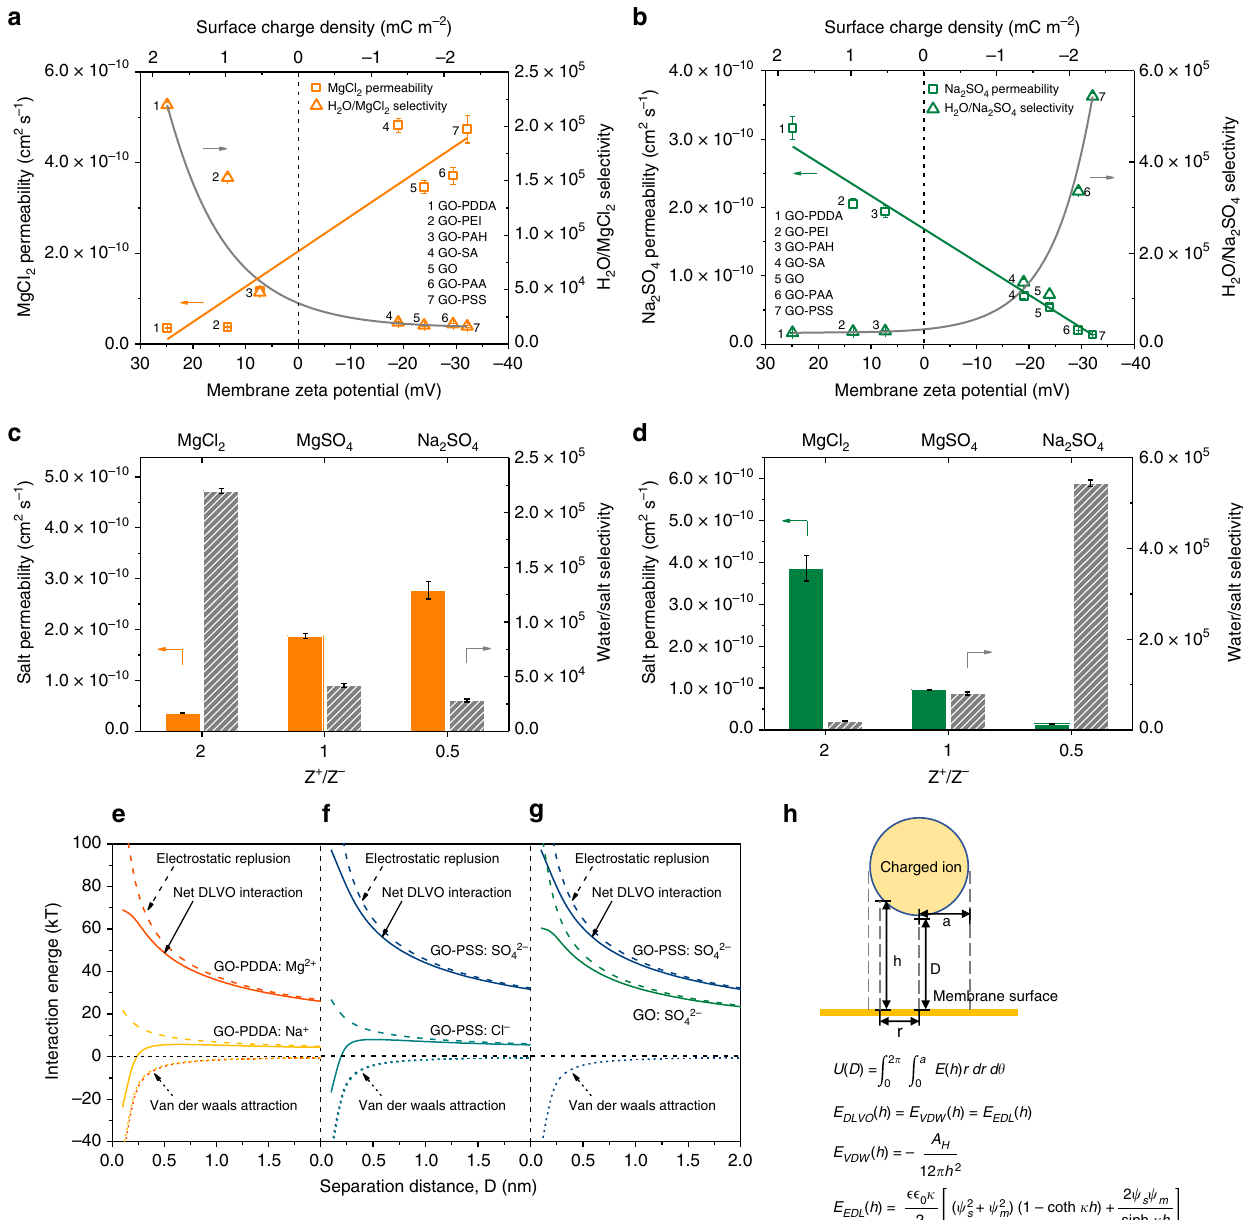
Fig. 2 Ion transport mechanism of surface-charged graphene oxide (GO) membranes. a MgCl 2 permeability and H 2 O/MgCl 2 selectivity and b Na 2 SO 4 permeability and H 2 O/Na 2 SO 4 selectivity of surface-charged GO membranes with various membrane zeta potentials obtained by streaming potential measurements and surface charge densities calculated from Gouy – Chapman equation. Orange squares are MgCl 2 permeability and orange circles are H 2 O/MgCl 2 selectivity; Green squares are Na 2 SO 4 permeability and green circles are H 2 O/ Na 2 SO 4 selectivity; Solid lines are best fi ts for the data. c , d Salt permeability and water/salt selectivity of c positively charged and d negatively charged GO membranes for MgCl 2 , MgSO 4 , and Na 2 SO 4 salts with varied Z + /Z – (ratio of the valence of cation and anion) values. e – g Surface element integration model predictions of Derjaguin – Landau – Verwey – Overbeek (DLVO) interaction energies between a charged ion and the charged membrane surface by adding Van der Waals attraction and electrostatic repulsion. e Orange: net DLVO interaction energy (solid line), electrostatic repulsion (dashed line), and Van der Waals attraction (dotted line) between Mg 2 + and the GO-PDDA membrane; Yellow: net DLVO interaction energy (solid line), electrostatic repulsion (dashed line), and Van der Waals attraction (dotted line) between Na + and the GO-PDDA membrane; f Navy: net DLVO interaction energy (solid line), electrostatic repulsion (dashed line), and Van der Waals attraction (dotted line) between SO 4 2 − and the GO-PSS membrane; Blue: net DLVO interaction energy (solid line), electrostatic repulsion (dashed line), and Van der Waals attraction (dotted line) between Cl − and the GO-PSS membrane; g Navy: net DLVO interaction energy (solid line), electrostatic repulsion (dashed line), and Van der Waals attraction (dotted line) between SO 4 2 − and the GO-PSS membrane; Green: net DLVO interaction energy (solid line), electrostatic repulsion (dashed line), and Van der Waals attraction (dotted line) between SO 4 2 − and the GO membrane. h Calculation formulas and schematic of the surface element integration (SEI) model in the calculation for DLVO interactions. Error bars represent standard deviations for three